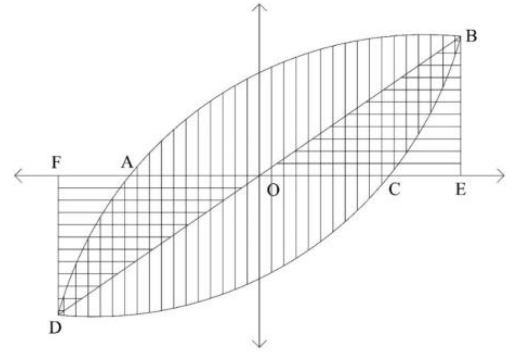
Figure 15. Calculation of the equivalent viscous damping coefficient. In Figure 15, Point O represents the origin point, Point B and D represent the maximum horizontal load point of hysteretic loops, Point A and C represents the point at which the hysteresis curve intersects the x-axis, and Point E and F represents the displacement corresponding to the maximum horizontal load point. The equivalent viscous damping coefficient of the three specimens is shown in Table 9. Table 9. Equivalent viscous damping coefficient ξ of the specimens.